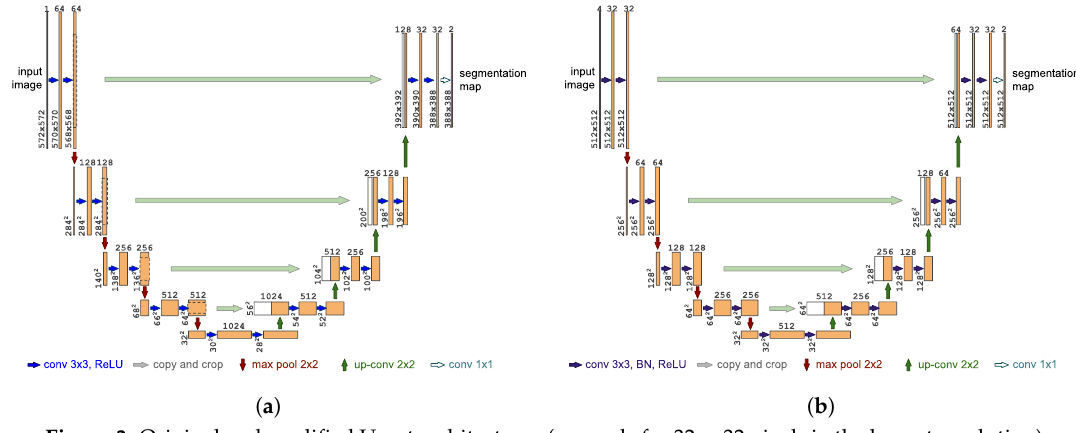
Figure 3. Original and modified U-net architectures (example for 32 × 32 pixels in the lowest resolution). Each blue box corresponds to a multi-channel feature map. The number of channels is denoted on top of the box. The x-y-size is provided at the lower left edge of the box. White boxes represent copied feature maps. The arrows denote the different operations. Based on Figure 1 from [21]. ( a ) Original U-Net architecture [21]; ( b ) Modified U-Net